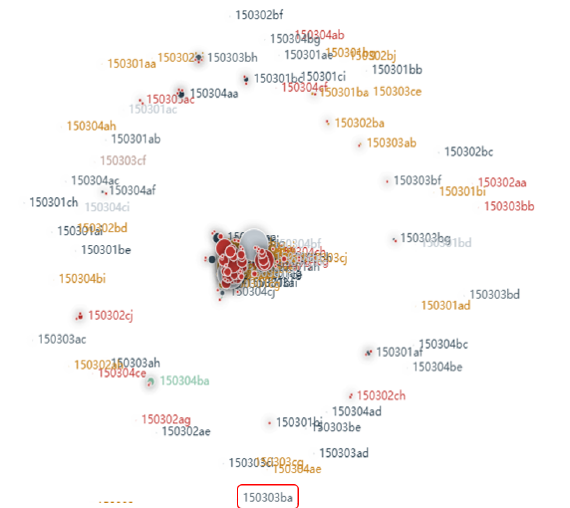
Figure 7. Layout of FR algorithm representing social relationship of student 150303ba.